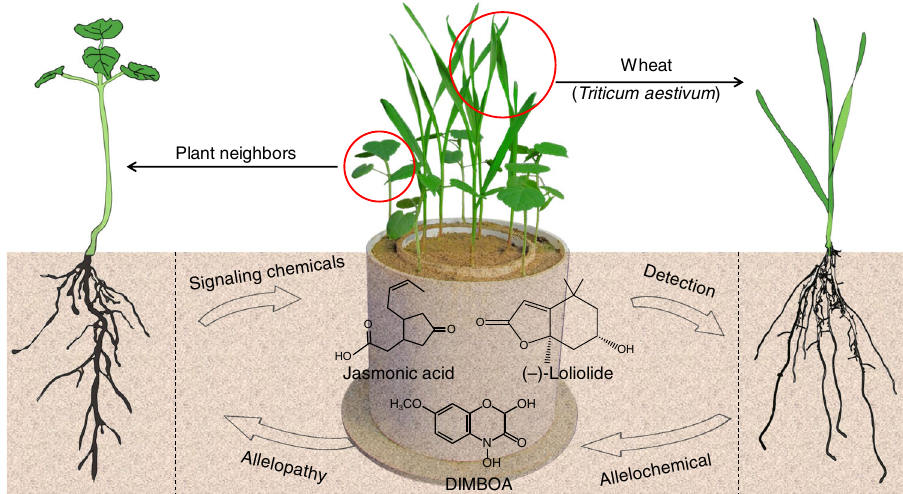
Fig. 5 The belowground chemical interactions between wheat and plant neighbors. The root-secreted signaling chemicals (-)-loliolide and jasmonic acid from plant neighbors; The allelochemical DIMBOA response in wheat. Image and every element of this image were created by C.H.K., S.Z.Z., and